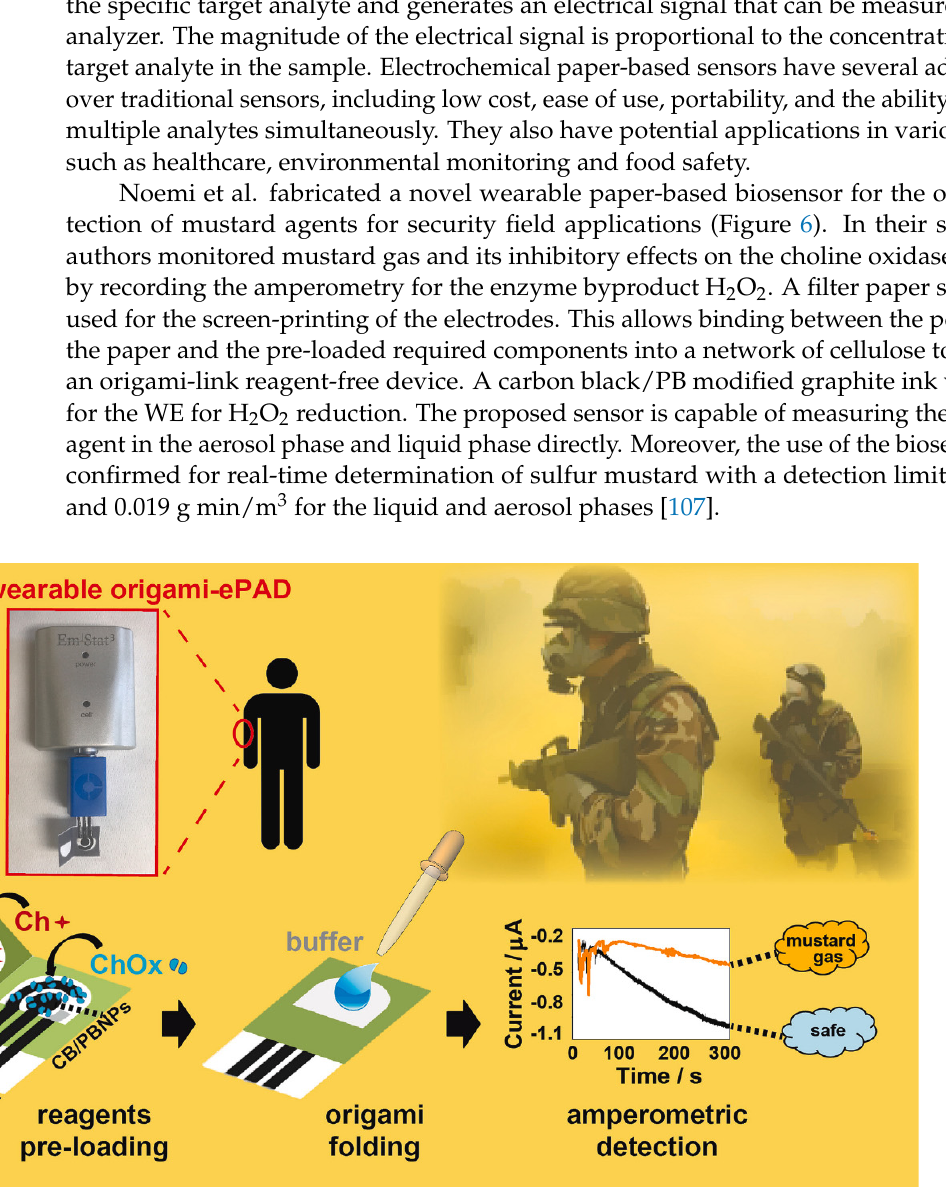
Figure 6. Schematic representation of working principle of the wearable origami-paper-based sensor and its on-site detection of mustard agents for security field application. Reproduced with the permission of [107]. Copyright 2019, Elsevier.